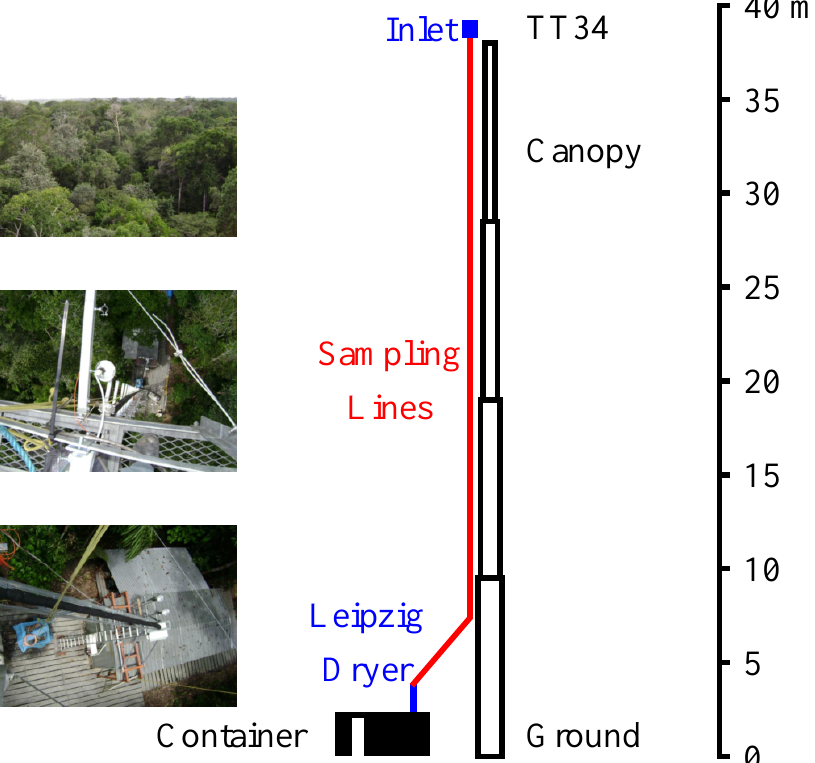
Fig. 1. Diagram of four-section telescopic tower (TT34), showing positions of inlet, canopy, sampling lines, dryer, and instrument container. Inset photos are shown larger in Fig. S2.